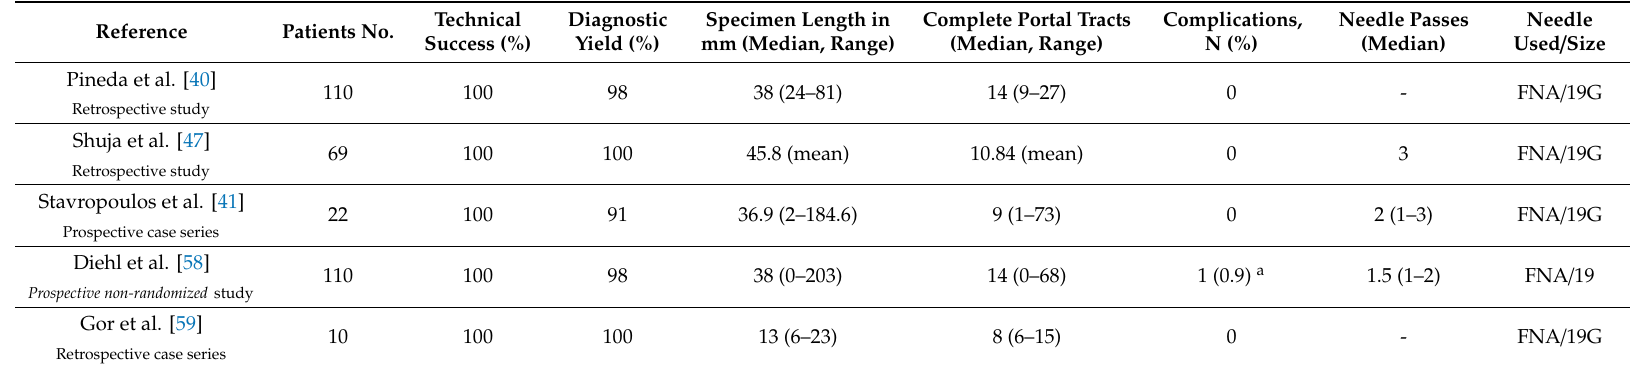
Table 2. Studies reporting the e ffi cacy and safety of EUS-FNA-guided liver biopsy in patients with chronic liver disease.